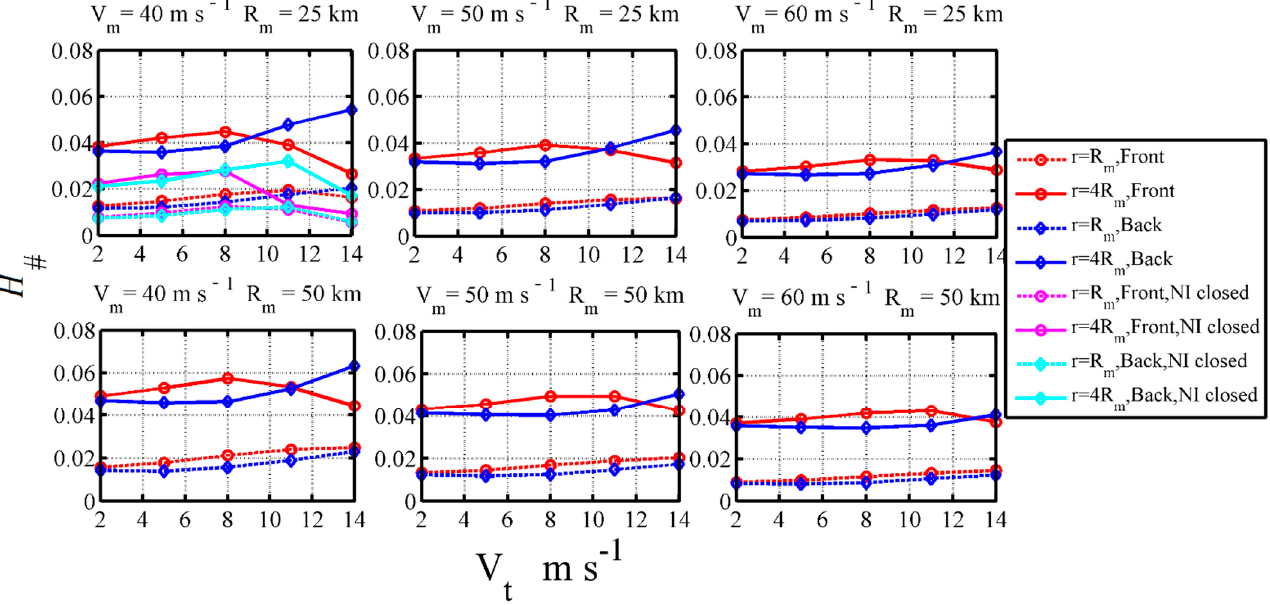
Figure 4. Modelling results of H # . The lines correspond to different radial distances, such as r = R m , and sectors in terms of front or back and model setting with nonlinear interaction (NI) closed or not.